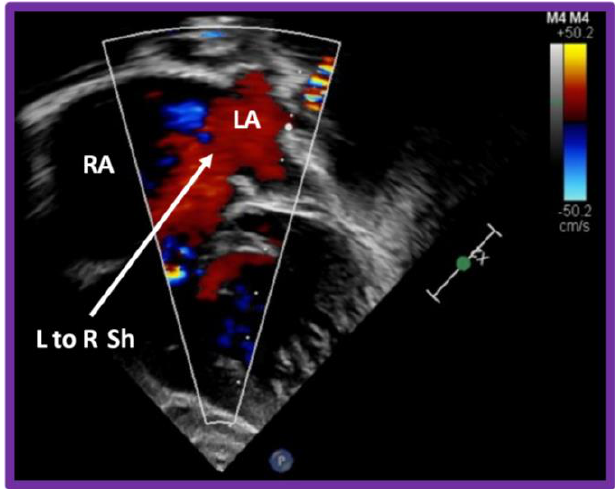
Figure 12. Selected video image from modified apical four-chamber views in a patient with mitral atresia illustrating unrestricted left to right shunt (L to R Sh) across the atrial setpal defect (arrow). Note the non–turbulent laminar flow. LA, left atrium; RA, right atrium.